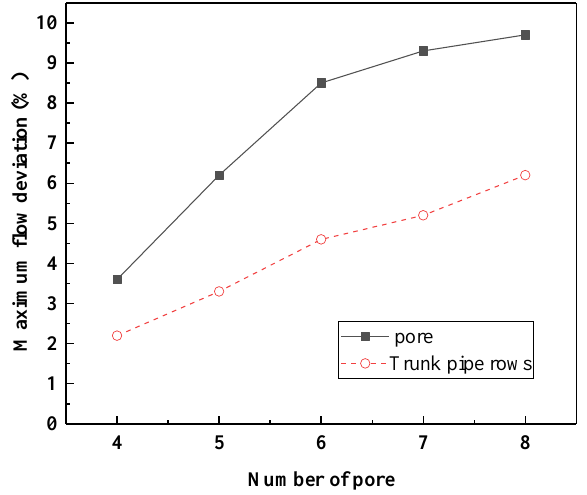
Figure 6. Maximum flow deviation for the water diffuser under different numbers of perforated pores.